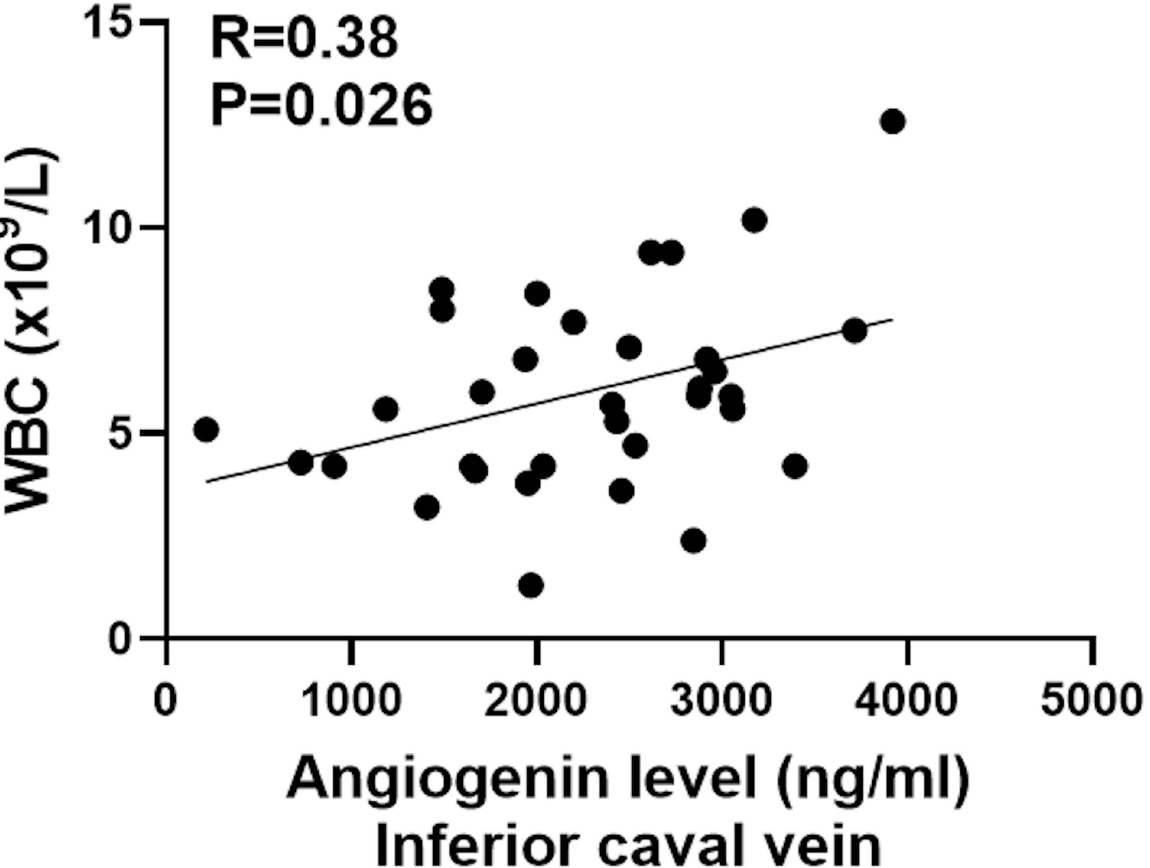
Fig 5. Correlation between inferior caval vein angiogenin concentrations and systemic white blood cell count at control angiography. Pearson’s correlation test was used for analysis of correlations between systemic WBC and inferior caval vein angiogenin level during control angiography. WBC: White blood cell count. n = 34.